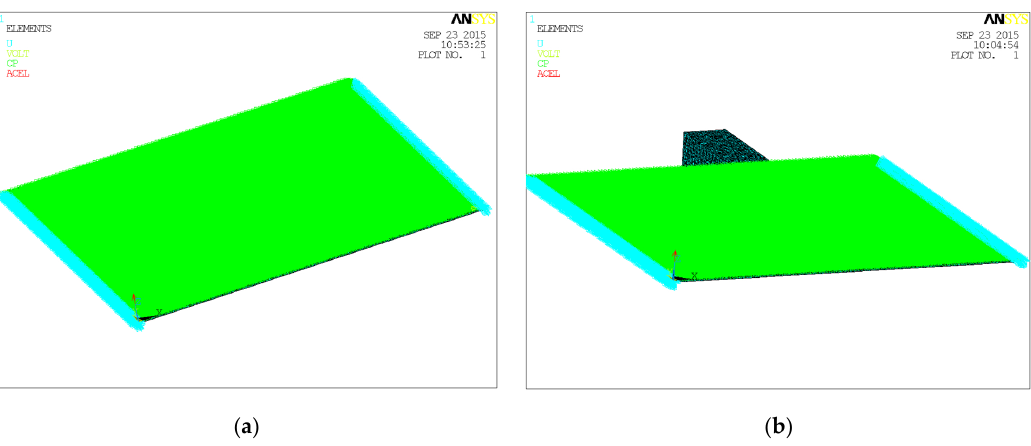
Figure 3. Models after meshing and defining constraints in simply supported beam fixation mode: ( a ) With mass block; ( b ) Without mass block.